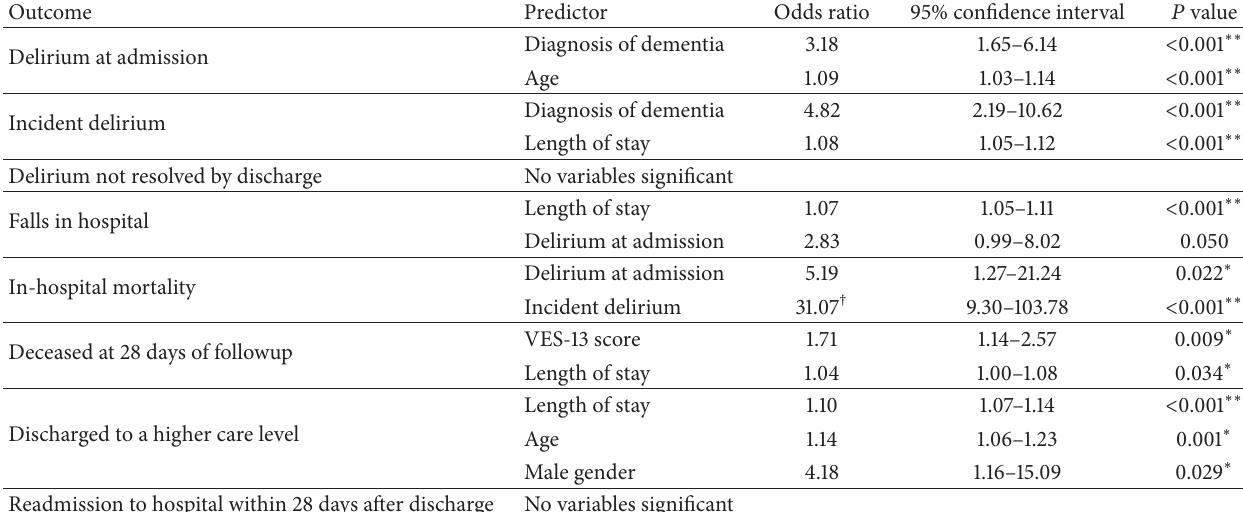
Table 3: Significant predictors of delirium and adverse outcomes in hospitalized older